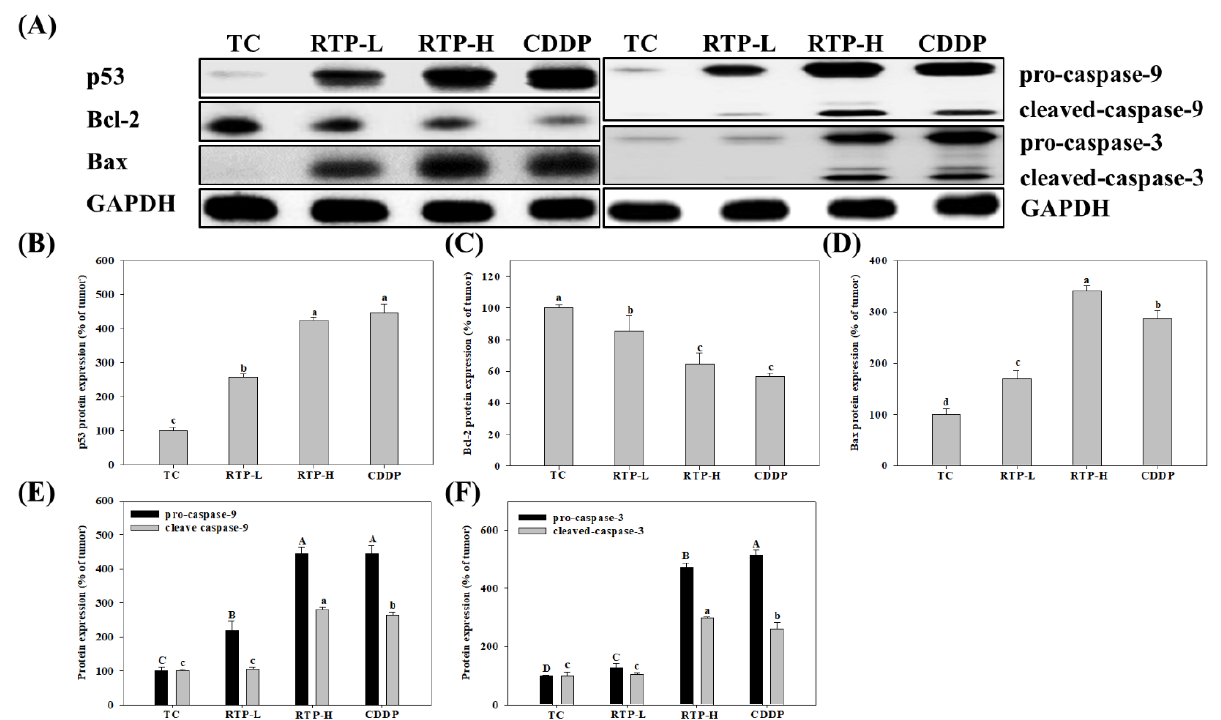
Figure 6. Effects of rutaecarpine (RTP) on ( B ) p53; ( C ) Bcl-2; ( D ) Bax; ( E ) caspase-9; and ( F ) caspase- 3 protein expression in tumor tissue from tumor-bearing mice. Male tumor-bearing nude mice were treated with RTP or cisplatin (CDDP) as described in the Methods. The tumor control (TC) was administered the vehicle only. ( A ): Western blots of protein and glyceraldehyde-3-phosphate dehydrogenase (GAPDH) ( B – F ): Densitometric analysis of Panel A. Values (mean ± SD, n = 9) not sharing a common capital (or a lower case letter) in each protein expression are significantly different ( p < 0.05). TC: tumor only; RTP-L: RTP by oral gavage at 25 mg/kg; RTP-H: RTP by oral gavage at 75 mg/kg; CDDP: intraperitoneally injected CDDP at 5 mg/kg.